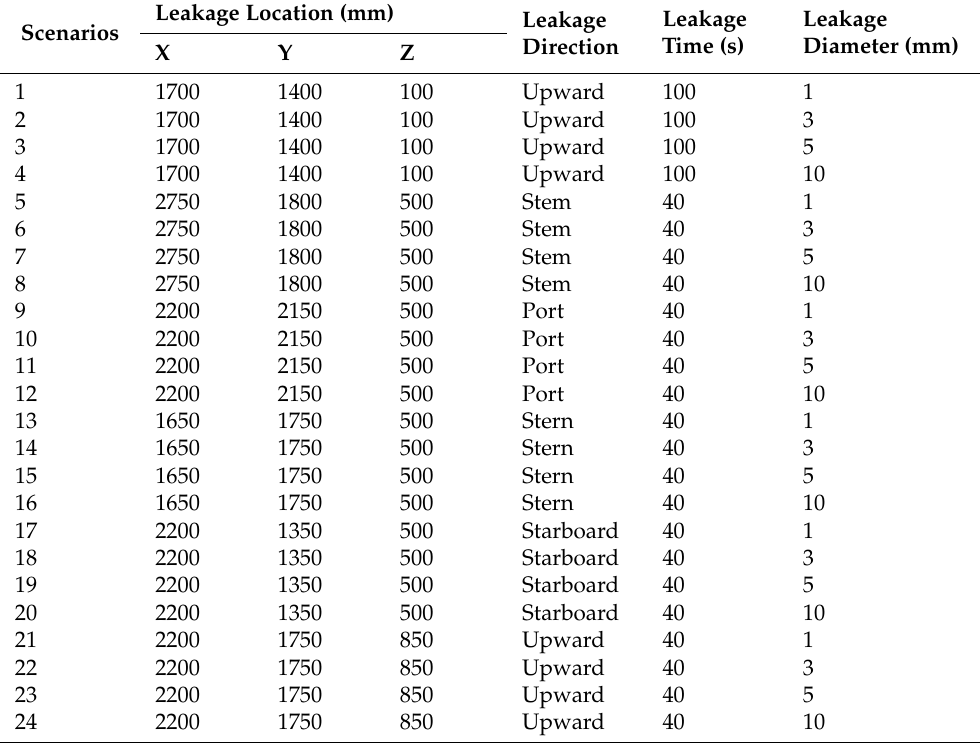
Table 5. Leakage scenarios and